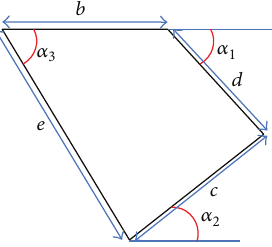
Figure 4: Example of small fingers which are placed at angle 𝛼 2 connected to the electrode.